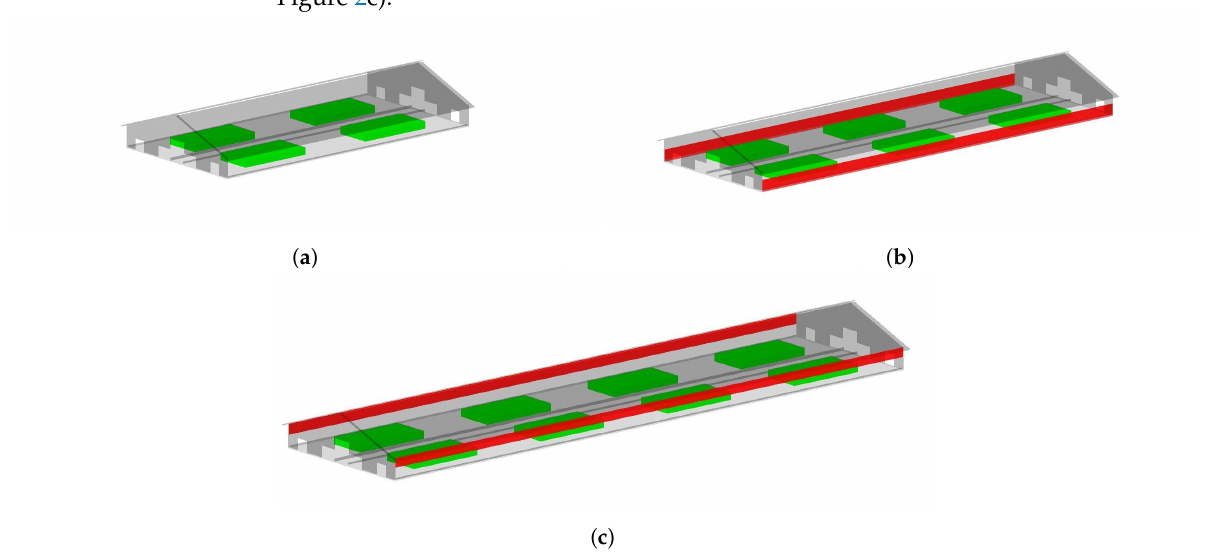
Figure 2. 3 of the 9 possible barn configurations for the study, the AOZs in green and the curtain in red. ( a ) barn L / W = 2 without curtain, ( b ) barn L / W = 3 with curtain “open up”, ( c ) barn L / W = 4 with curtain “open